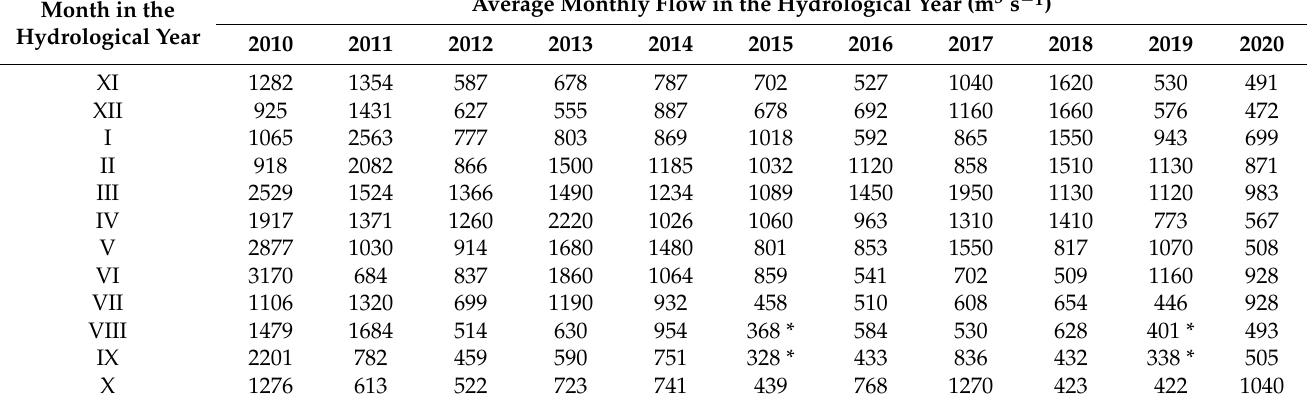
Table 3. Average monthly flows of the Wisła River in the estuary profile in 2010–2020 [23].